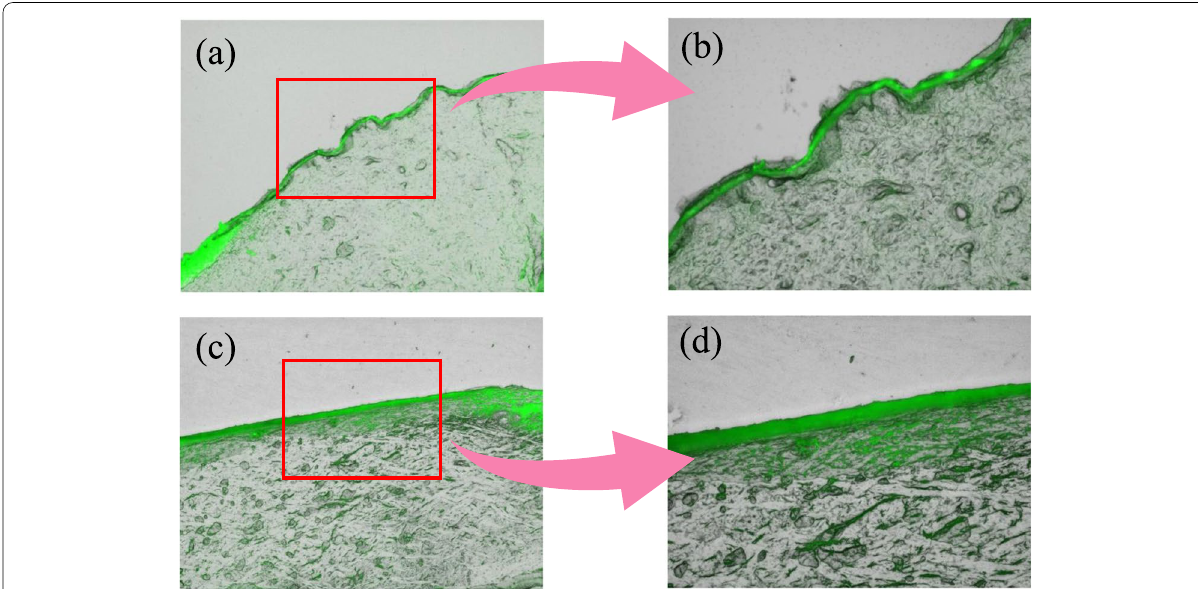
Fig. 11 Fluorescence microscope images of the epidermal side of YMP skin. a , b Intact NOB; c , d EVP (Sol/ASC-DP/NOB b , d objective ×